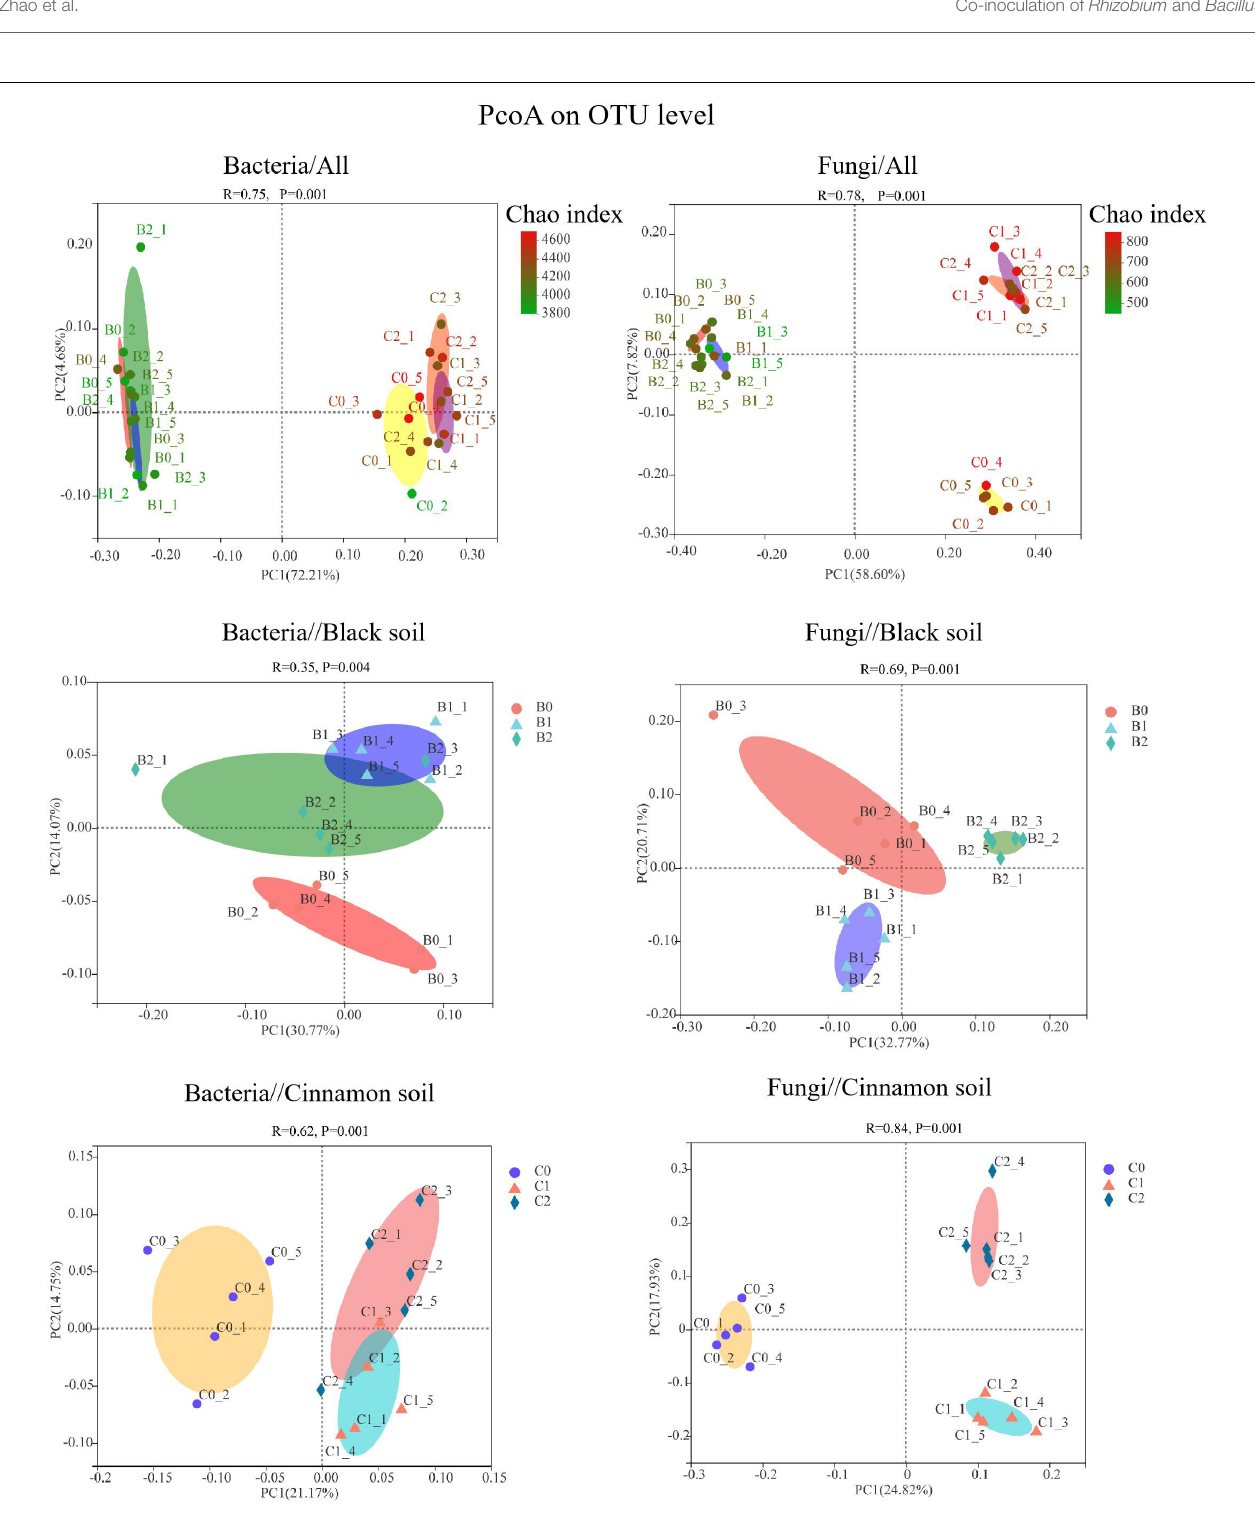
FIGURE 1 | PCoA based on Bray–Curtis dissimilarities showing the difference in bacterial and fungal community in black soil and cinnamon soil. B0, B1, and B2 means no-inoculation, inoculation of Bradyrhizobium japonicum 5038, and co-inoculation of Bradyrhizobium japonicum 5038 and Bacillus aryabhattai MB35-5 in the black soil, and C0, C1, and C2 means no-inoculation, inoculation of Bradyrhizobium japonicum 5038, and co-inoculation of Bradyrhizobium japonicum 5038 and Bacillus aryabhattai MB35-5 in the cinnamon soils.